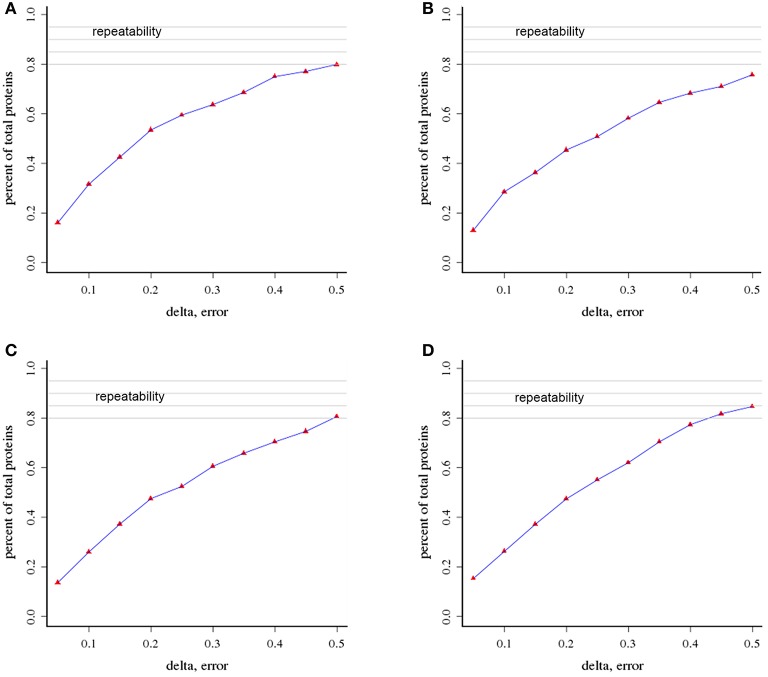
Analysis of the repeatability of protein identification (A) HP vs. PIP; (B) HP vs. PIP-60 (C) PIP-20 vs. PIP-60; (D) PIP vs. PIP-20.